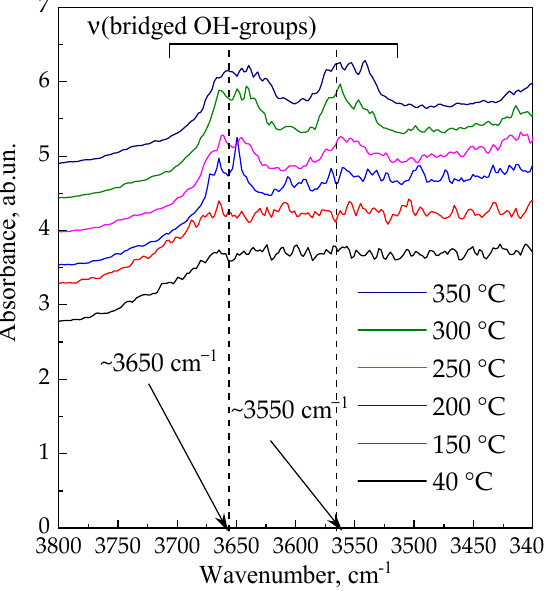
Figure 5. In situ IR-spectra of the am sample during its heating from room temperature to 350 °C. There are no significant features of spectra below 200 °C, which is due to the presence of physically adsorbed water within the porous structure. When the sample is heated up to 200 °C, the absorbance band at 3650 cm − 1 appears in the spectrum. This band corresponds to bridged OH groups localized in supercages [70–76]. This is consistent with N 2 adsorption; the am -200 sample is characterized by the largest adsorption capacity due to the replacement of relatively large and heavy alkaline cations with small and light protons in the SIII positions. An increase in the temperature above 200 °C results in the manifes- tation of the second band at 3550 cm − 1 , which corresponds to –Si–O(H)–Al– groups in so- dalite cages [70–81]. The in situ information on the proton sites formed in the am sample was supple- mented by IR spectroscopy data, confirming the presence of residual NH 4+ groups in am - 200 and am -300 samples. Figure 6 shows the IR spectra of am -200 and am -300 samples before pyridine or CO adsorption. As discussed above, OH groups bands at 3580 cm − 1 (LF band) and 3657 cm − 1 (HF band) belong to bridging OH groups localized in sodalite cages and large cavities [70–72,82] of type-X zeolites, respectively. In addition to stretching vibration bands of OH groups, there are absorbance bands at 1450, 1680 and 2925, 3090 and 3250 cm − 1 . These are caused by the deformation (symmetrical and asymmetrical) and stretching vibrations of ammonium ions. Such bands are typical of the NH 4+ ions localized in various solid acids [83–85]. Thus, they indicate residual –Si–O(NH 4+ )–Al– groups in both ammonia-modified samples. The intensity of the 1450 cm − 1 band in the am -300 sample is about four times lower compared to that for the am -200 sample (Figure 6, Curves 1 and 2), which proves the sequential transformation of ammonium ions to proton sites with temperature in- crease.